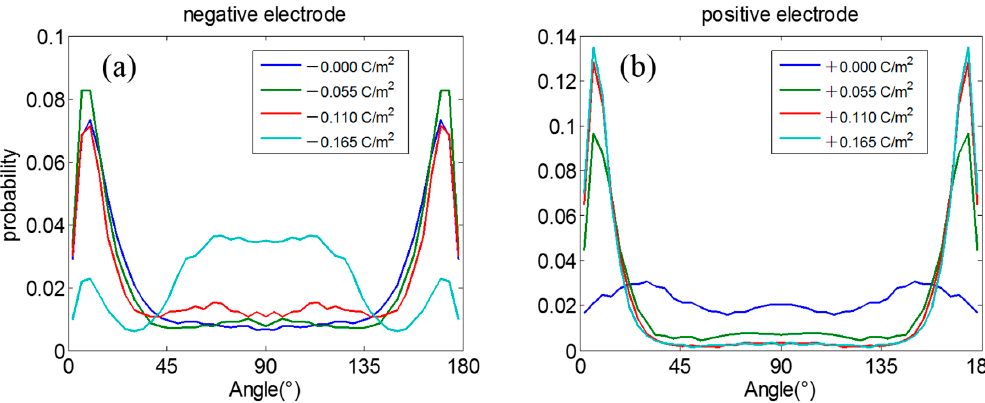
Figure 6. ( a ) The orientation distribution probability of the angle formed between the cation [Emim] + and the negatively-charged electrode; ( b ) the orientation distribution probability of the angle formed between the anion [CNPyr] − and the positively-charged electrode at varying charge densities.